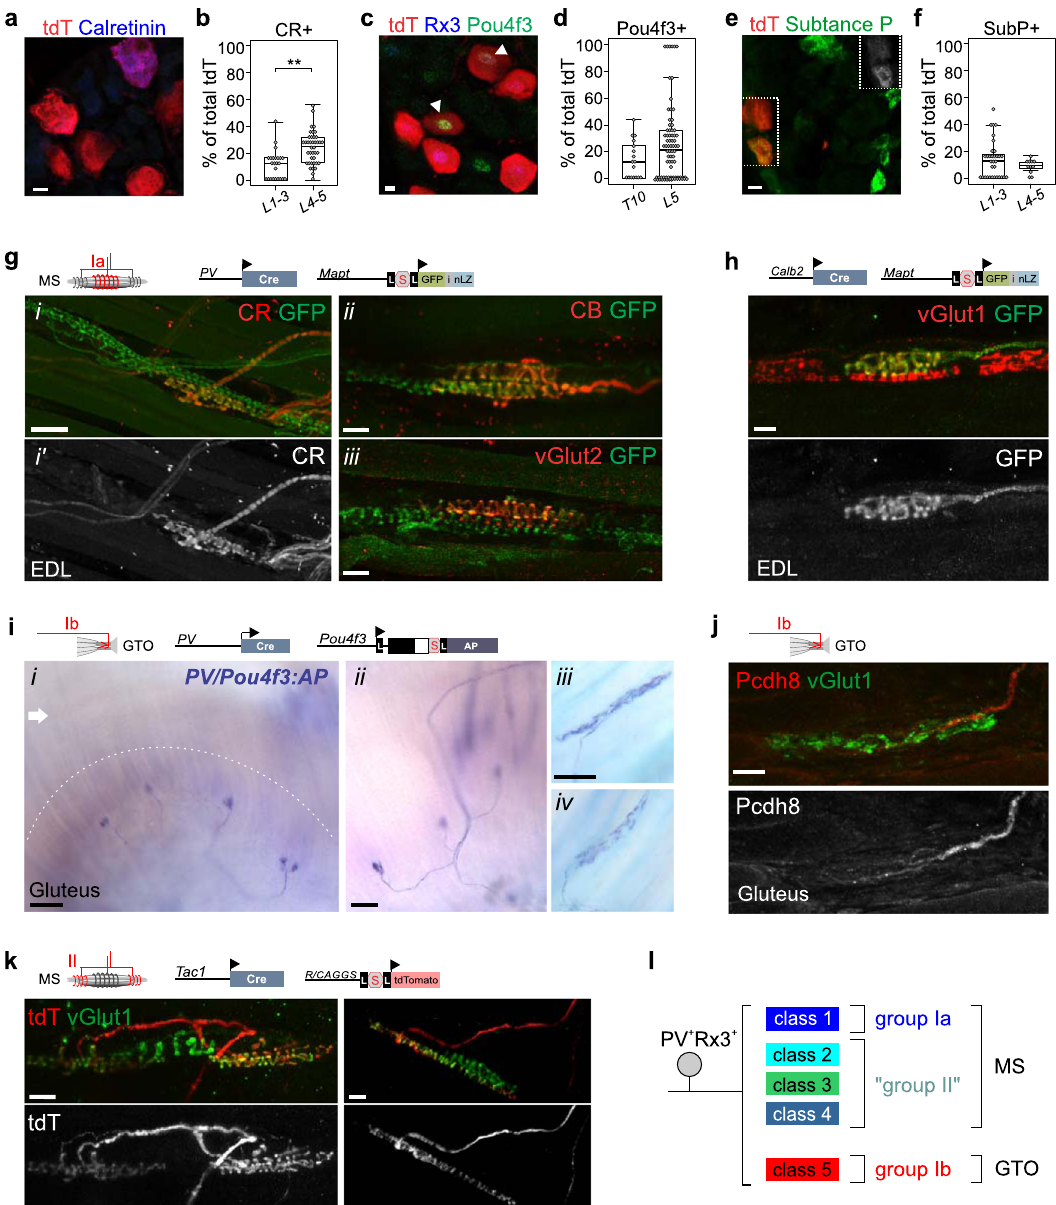
Fig. 4 Molecular distinct pSN clusters segregate with MS or GTO afferents. a Expression of Calretinin and tdT in ≥ p56 lumbar DRG of PVRx3:tdT mice. b Percentage of CR + tdT + neurons (of total tdT + ) in adult PVRx3:tdT DRG. Mean percentage± S.E.M. CR(L1-3): 11.6 ± 2.3%, n = 24 sections; CR(L4-5): 23.9 ± 1.9%, n = 40 sections, p < 0.001 (two-sided Mann – Whitney U test). c Expression of Pou4f3, Runx3, and tdT in ≥ p56 lumbar DRG of PVRx3:tdT mice. Arrowheads indicate Pou4f3 + Rx3 + tdT + neurons. d Percentage of Pou4f3 + tdT + neurons (of total tdT + ) in adult PVRx3:tdT DRG. Mean percentage± S.E.M. Pou4f3(T10): 13.9 ± 3.6%, n = 17 sections; Pou4f3(L5): 25 ± 3.2%, n = 78 sections. e Expression of Substance P and tdT in ≥ p56 lumbar DRG of PVRx3:tdT mice. Boxed area is also shown in top right corner to illustrate expression of Substance P. f Percentage of Sub. P + tdT + neurons (of total tdT + ) in adult PVRx3:tdT DRG. Mean percentage ± S.E.M. SubP(L1-3): 13.8 ± 2.5%, n = 33 sections; SubP(L4-5): 9.0 ± 1.6%, n = 11 sections. g Expression of Calretinin (CR) (i, i ′ ), Calbindin 1 (CB) (ii), and vGlut2 (iii) in GFP + muscle spindle (MS) afferents of p12 (i, i ′ ) or adult ( ≥ p56) (ii, iii) muscle of PV:Cre; Mapt:lxp- STOP-lxp:mGFP-iNLZ ( PV:GFP ) mice. CR, CB, and vGlut2 expression is observed in GFP + MS afferents that innervate the equatorial region of the muscle spindle. h Expression of vGlut1 and GFP in a muscle spindle (MS) of p18 EDL muscle of Calb2:Cre; Mapt:lxp-STOP-lxp:mGFP-iNLZ ( Calb2:GFP ) mice. Similarly as observed for Calretinin protein, in Calb2:GFP mice, expression of GFP labels MS afferents that innervate the equatorial region of the spindle. i Alkaline phosphatase (AP) labeling of GTO afferents in gluteus muscle of PV:Cre; Pou4f3:lxp-STOP-lxp:AP ( PV/Pou4f3:AP ) at p2 (i, ii), and at ≥ p56 (iii, iv) mice. Dashed line in (i) indicates area of the myotentinous junction where GTOs reside. Arrow indicates muscle area where MSs are generally located. j Pcdh8 expression localizes to vGlut1 + GTO afferents in p12 gluteus muscle of wild type mice. k tdT + MS afferents in EDL muscle of p20 Tac1:Cre; Ai14:tdTomato ( Tac1:tdT ) animals. l Summary of molecularly distinct pSN subclasses and their association with either MS (group Ia, putative group II) or GTO (group Ib) muscle receptors. In g – l , schematics indicate pSN subtype highlighted, and alleles used, in images below. Similar data obtained from at least three ( a , c , e , g – i ), two ( k ), or one ( j ) biological replicates. In boxplots ( b , d , f ), boxes indicate medians and 25th/75th percentiles, and whiskers extend to the furthest point <1.5 standard deviations from the mean. Scale 10 ( a , c , e ) 20 ( g (ii), g (iii), h , j ) or 50 ( g (i)) μ m.